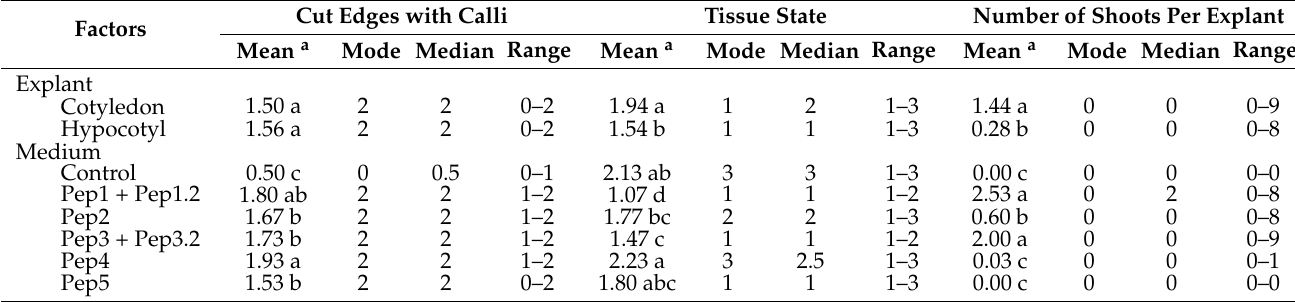
a For each factor, means separated by different letters are significantly different at p < 0.05 according to the non-parametric pairwise Wilcoxon